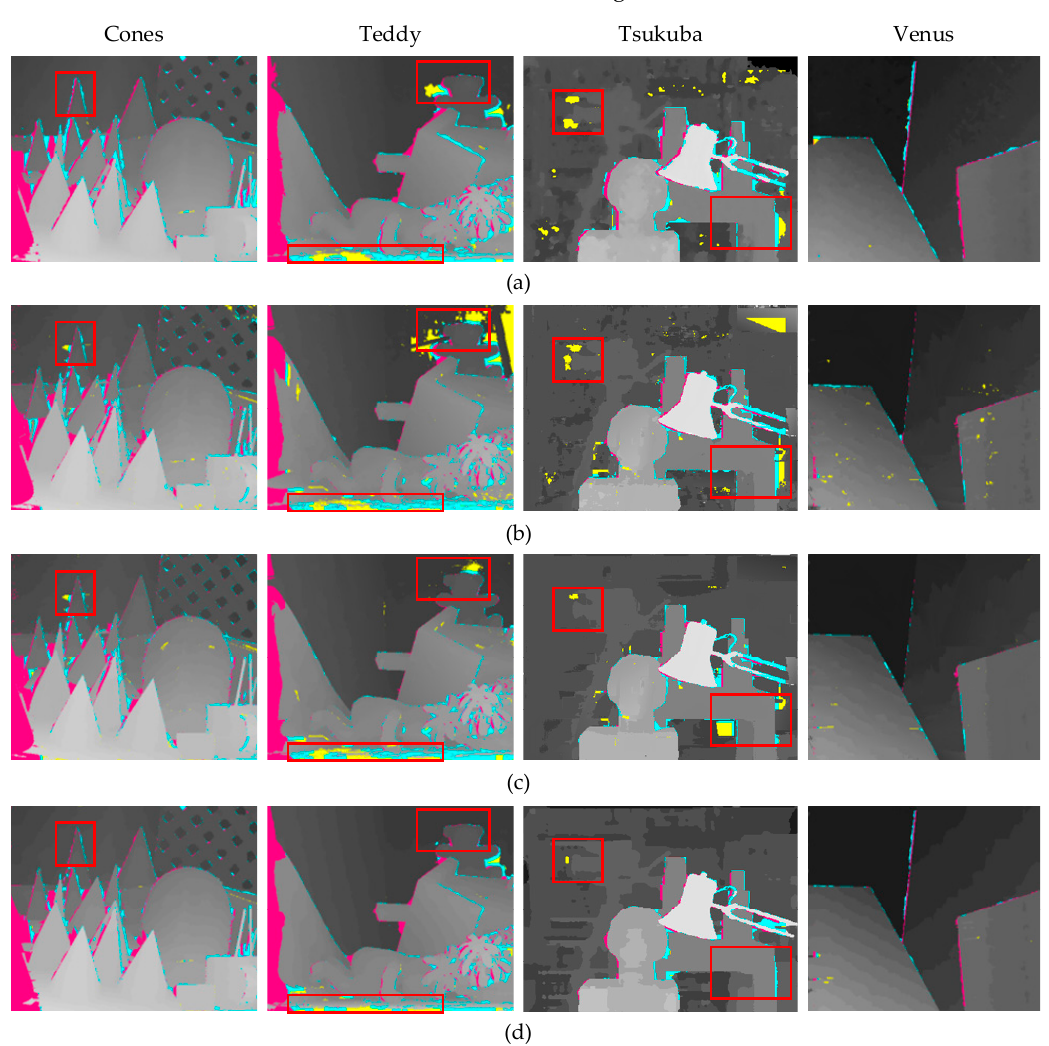
Figure 6. Disparity maps obtained by four different algorithms: ( a ) SGM (traditional SGM algorithm [11]); ( b ) CSCA + BOX (the fastest matching speed under CSCA [16]); ( c ) CSCA + GF (the best matching accuracy under CSCA [16]); and ( d ) SGM-MSIF (this paper). Magenta represents All error. Yellow represents Non-occ error and cyan represents Disc